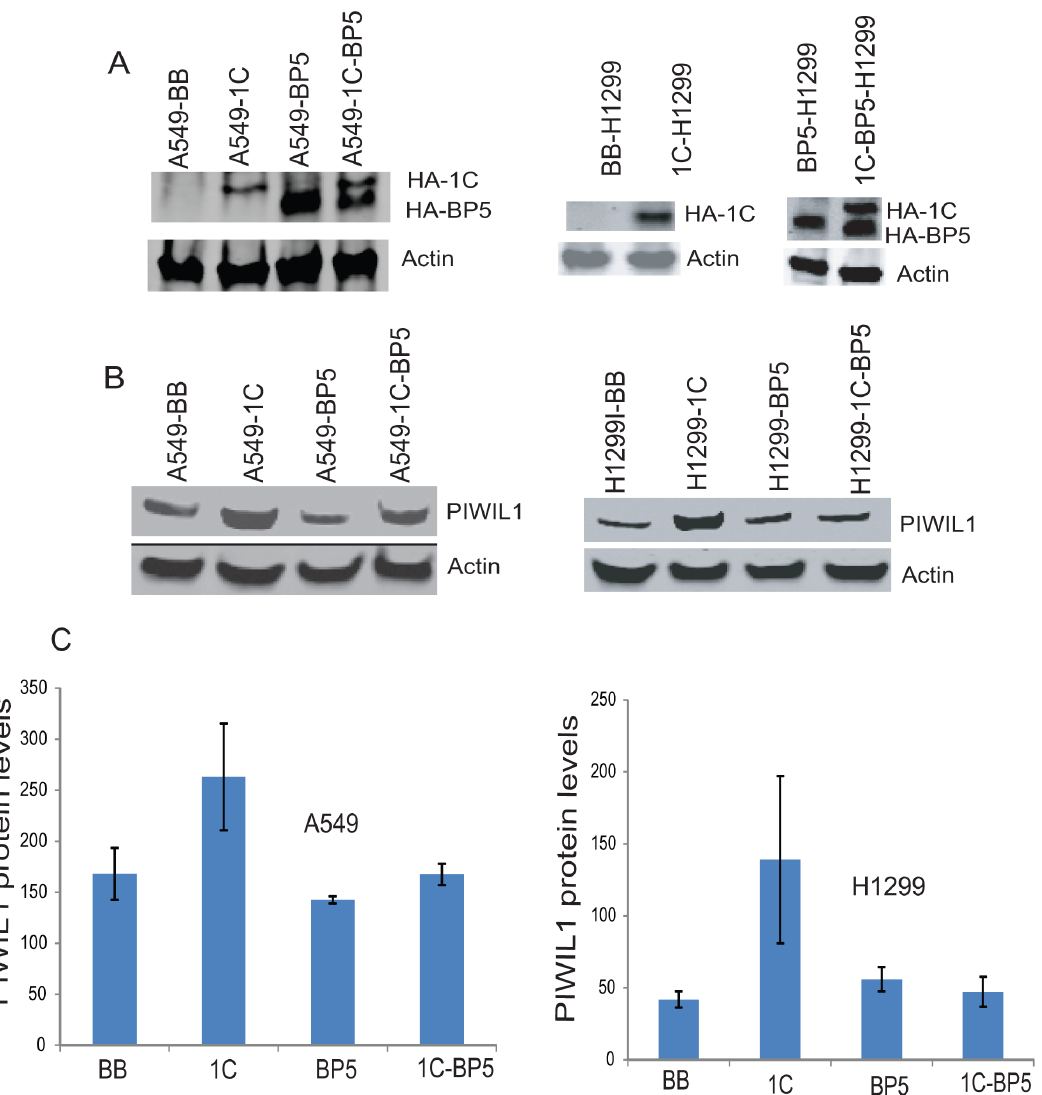
Figure 8 . Effect of RASSF1C-IGFBP5 interaction on PIWIL1 protein levels. (A) Western blot analysis of NCI-H1299 and A549 cells stably transduced with MLV-backbone (BB), MLV-HA-RASSF1C (1C), MLV-HA-IGFBP-5 (BP5), and co-transduced with both MLV-HA-RASSF1C and –IGFBP-5 (1C-BP5) and treated with 1 m g/ml doxycycline for 48 h. The anti-HA tag antibody detected a HA-RASSF1C and HA-IGFBP-5 fusion protein in cells that over-expressed each alone and those that co-expressed them both. The fusion protein was visualized using fluorescently labeled secondary antibodies. (B) Western blot analysis of A549 and H1299 lung cancer cells stably transduced with MLV-backbone (A549-BB and H1299-BB), MLV-HA- RASSF1C (A549-1C and H1299-1C), MLV-HA-IGFBP-5 (A549-BP5 and H1299-BP5), and MLV-HA-RASSF1C/MLV-HA-IGFBP-5 A549-1C-BP5 and H1299-1C- BP5). The anti-PIWIL1 antibody was used to probe the Western blot. PIWIL1 is up-regulated in A549 and NCI-H1299 cells over-expressing RASSF1C, but not in cells that express IGFBP-5 or co-express both IGFBP-5 and RASSF1C. (C) Shows normalized PIWIL1 protein levels to actin (loading control) with standard deviations, data represents three independent blots.